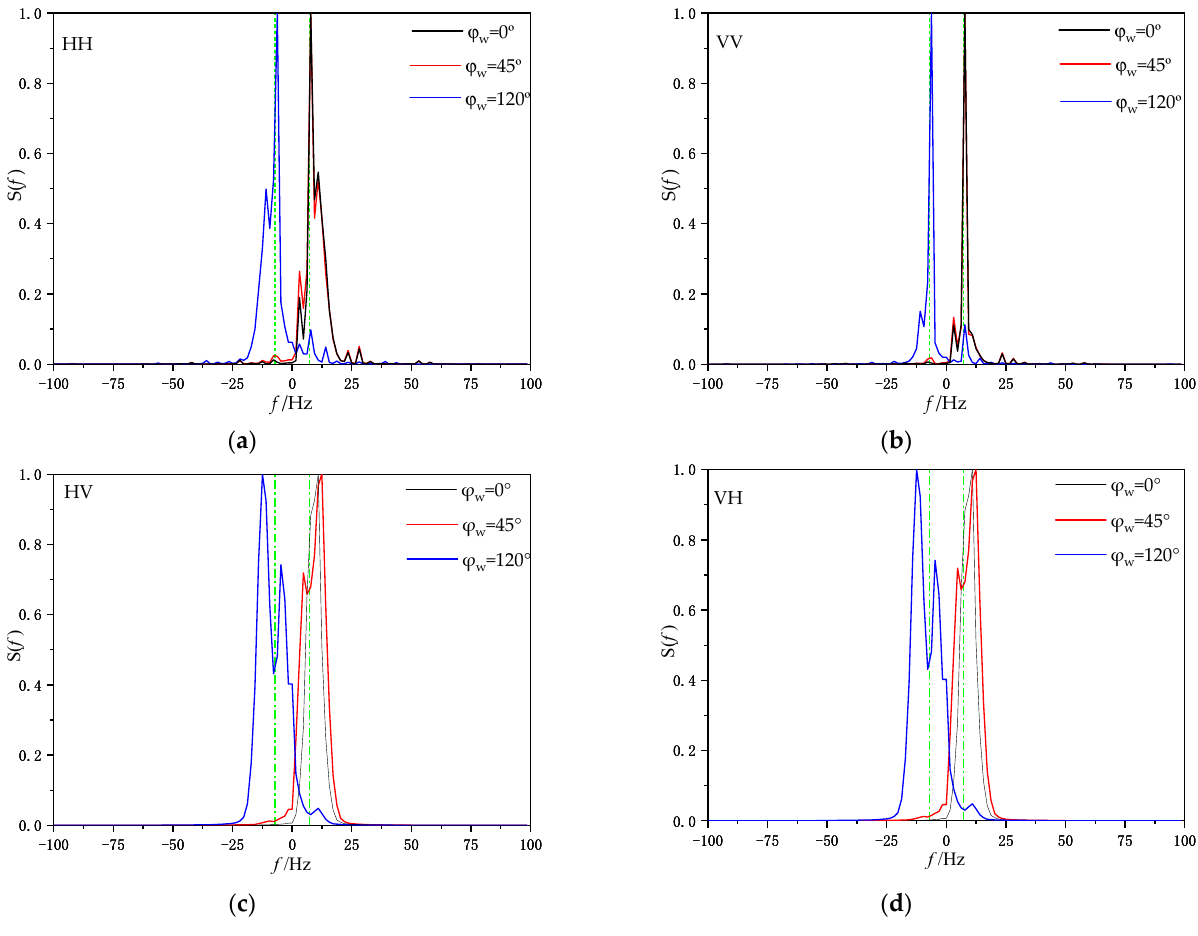
Figure 14. Doppler spectra under different wind directions for ( a ) Doppler spectrum at HH polarization, ( b ) Doppler spectrum at VV polarization, ( c ) Doppler spectrum at HV polarization, and ( d ) Doppler spectrum at VH polarization.